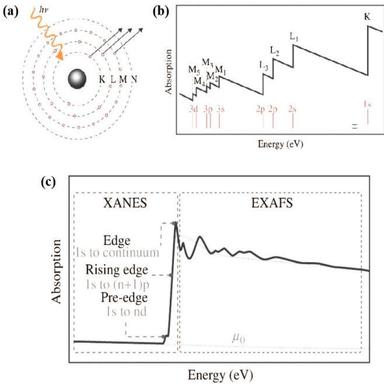
(a) Schematic representation of core electron excitation from the K, L, and M shell by incoming light with sufficient energy. (b) Schematic representation of absorption edges. (c) Typical example of an X-ray absorption spectrum, the X-ray absorption near-edge structure (XANES) and the extended X-ray absorption fine structure (EXAFS).